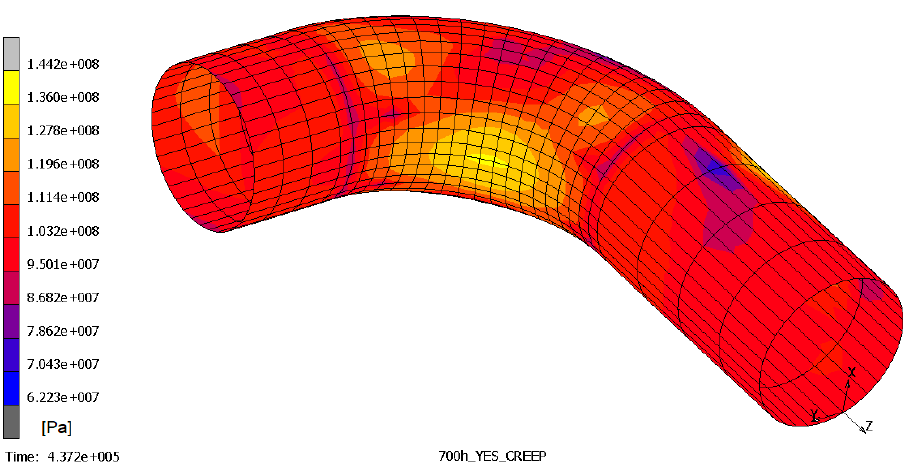
Figure 7. Equivalent von Mises stress, bottom layer—case 5.